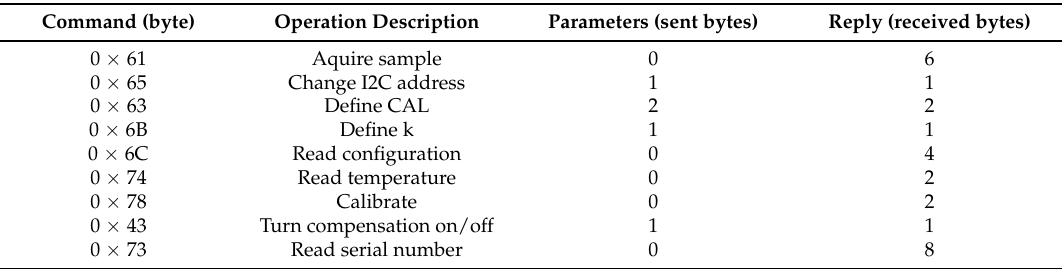
Table 3. Command to configure and operate the probe.